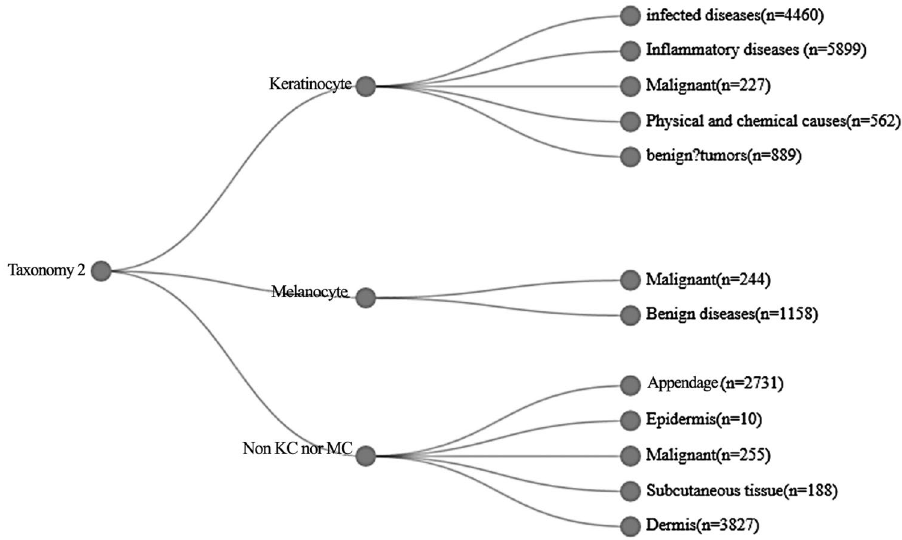
Figure 2. The first three levels contained by the taxonomy